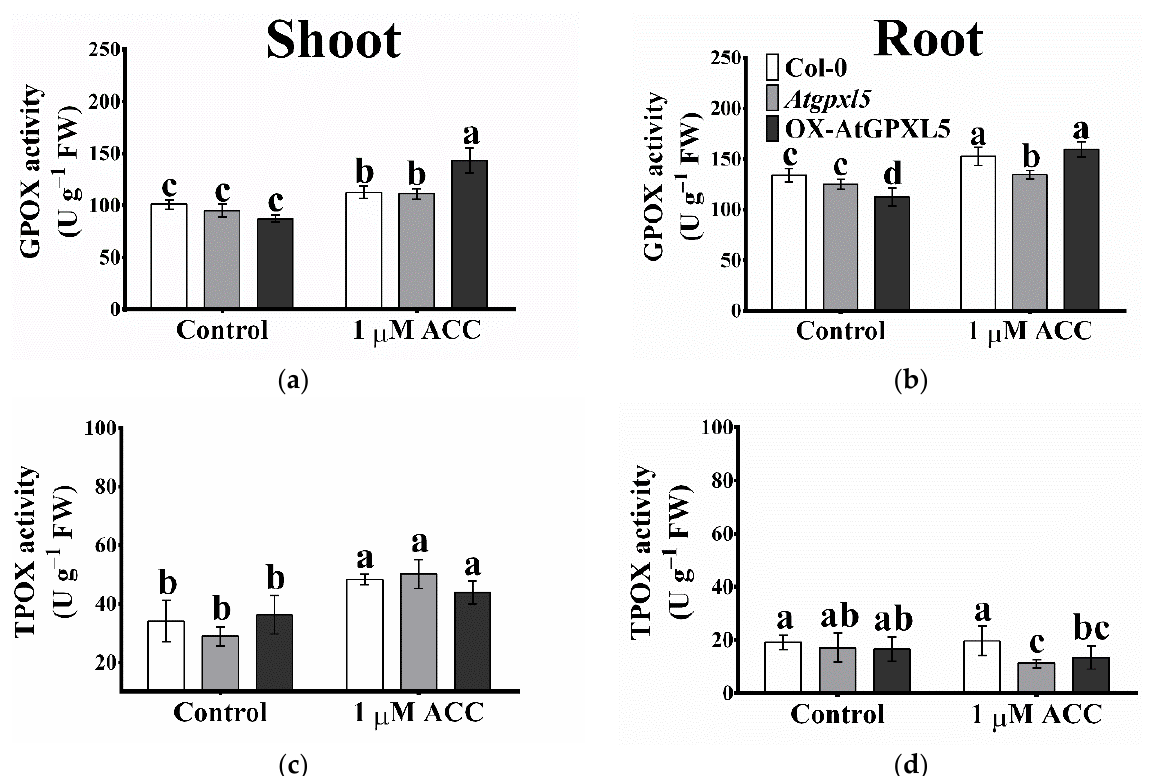
Figure 5. Effect of one- day 1 μM ACC treatment on the glutathione peroxidase (GPOX) activity ( a , b ) and thioredoxin peroxidase (TPOX) activity ( c , d ) in shoots and roots, respectively, of 6-week-old Arabidopsis thaliana wild type (Col-0), Atgpxl5-1 insertional mutant ( Atgpxl5 ) and AtGPXL5-overexpressing (OX-AtGPXL5) plants. Mean ± SD, n = 3. Data were analysed using one-way ANOVA followed by Duncan’s test. Different letters represent data considered statistically significant at p ≤ 0.05.